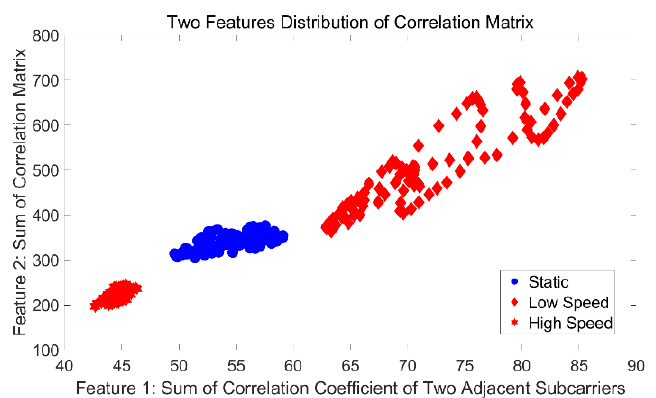
Figure 9. The distribution of our proposed features for classifying static, low speed, and high speed.